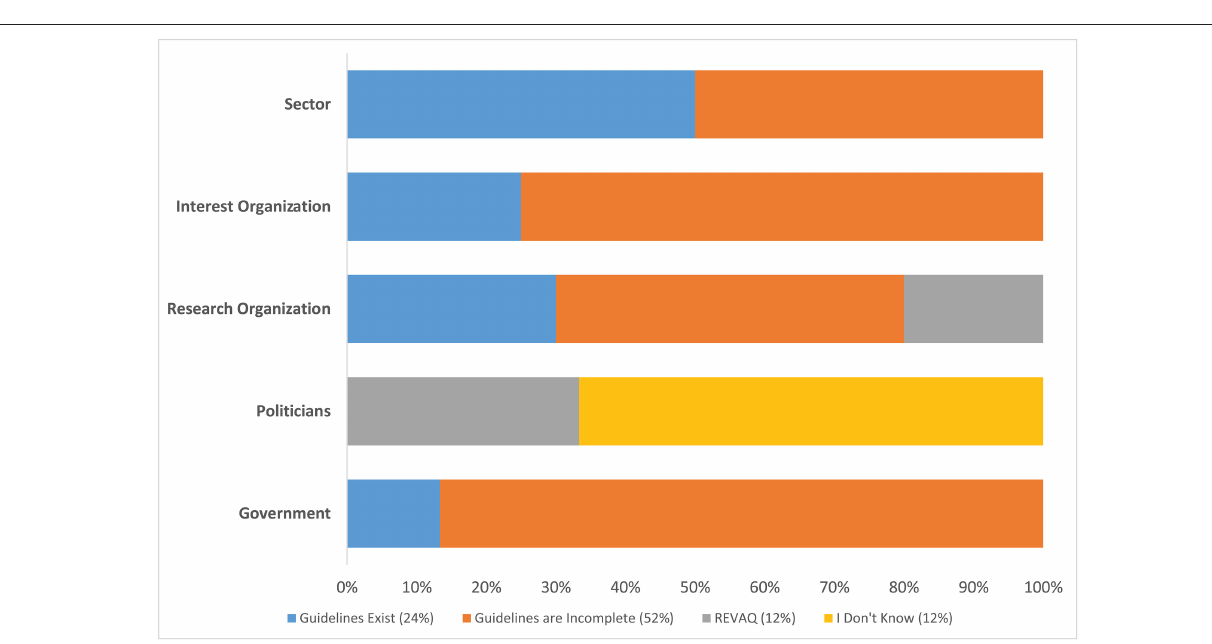
Respondents from all stakeholder categories